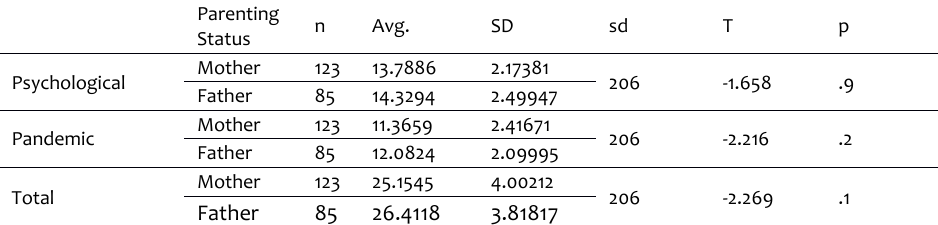
Table 1. The mean scores and t-test results of the reactions of the children to the pandemic according to the parenting status of the parents (n=208)